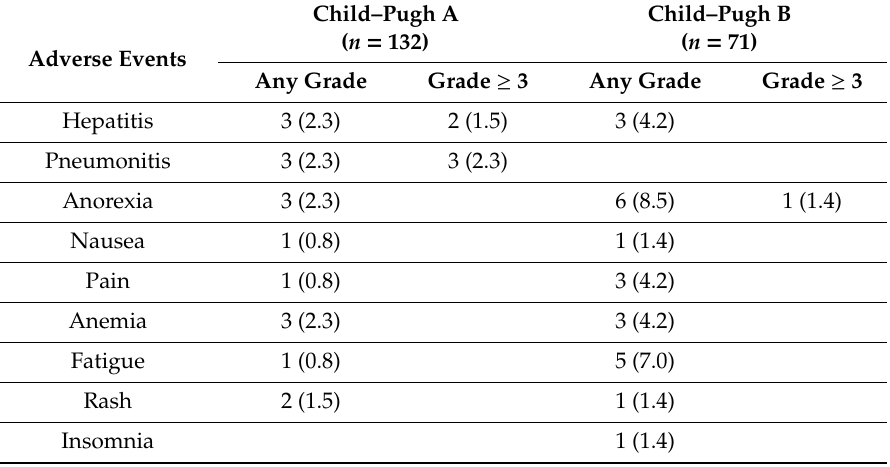
Table 7. Adverse events requiring discontinuation or dose